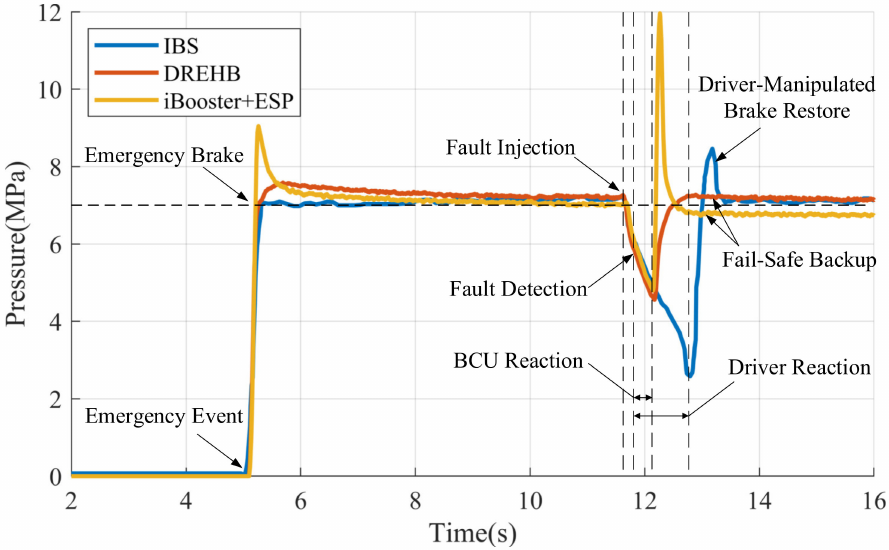
Figure 16. The test results of comparative validation of fail-safe